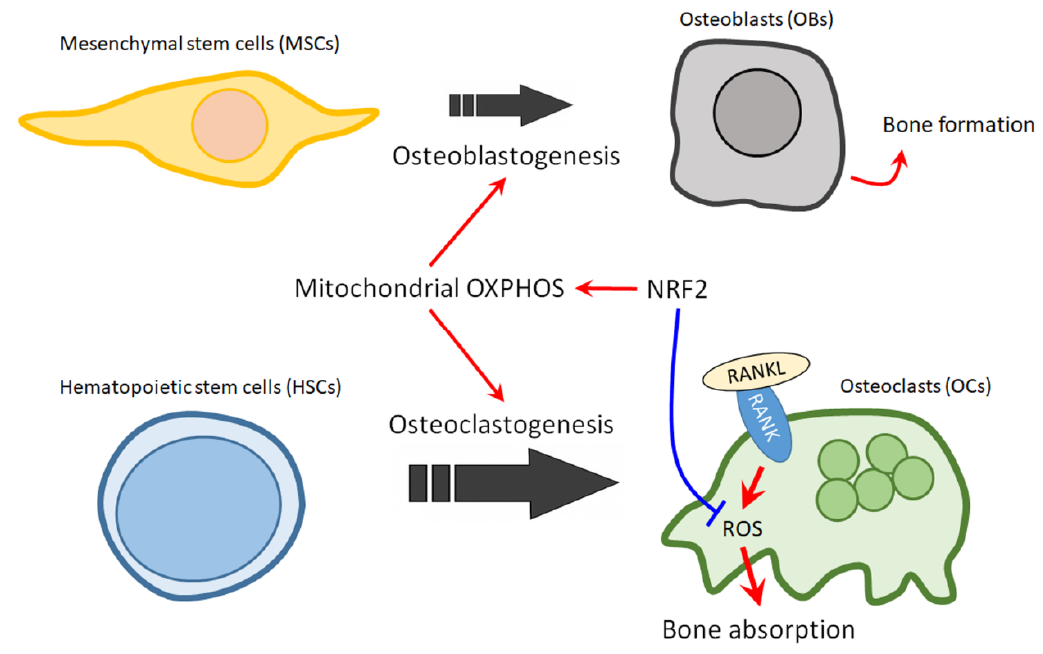
Figure 4. The role of NRF2 in mitochondrial regulation of bone homeostasis in MBD. The balance of OCs and OBs is impaired in osteolytic bone lesions, where OB activity is suppressed while the osteoclastogenesis is strongly upregulated. Activation of NRF2 could promote osteoblastogenesis, while restraining uncontrolled osteoclastogenesis. Red arrows indicate active effect; Blue bar arrow indicates suppressive effect.